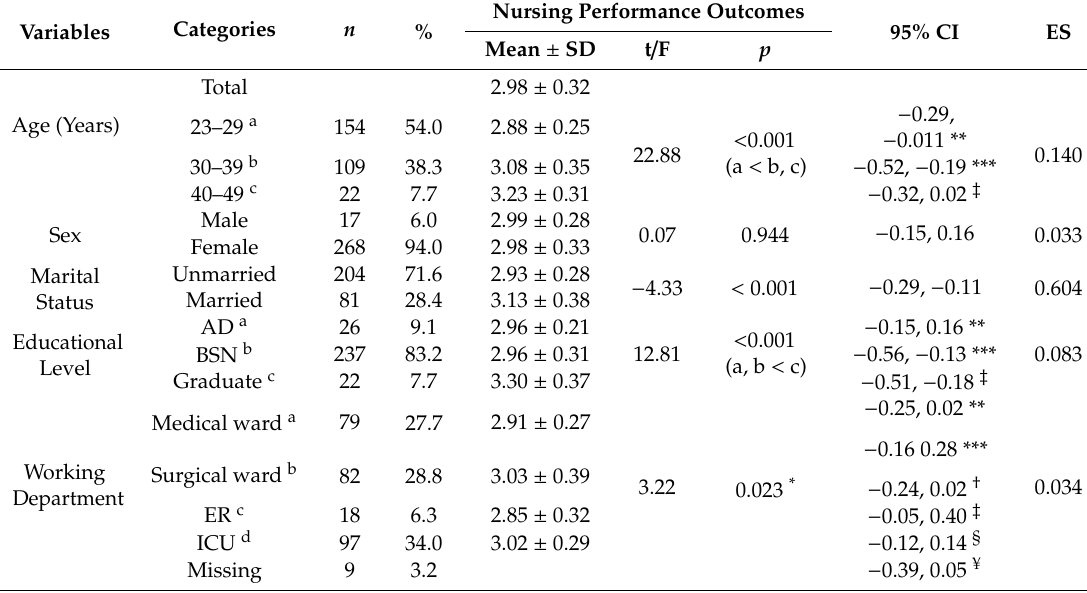
Table 1. Di ff erences in nursing performance outcomes according to demographic and job-related characteristics of participants ( n =